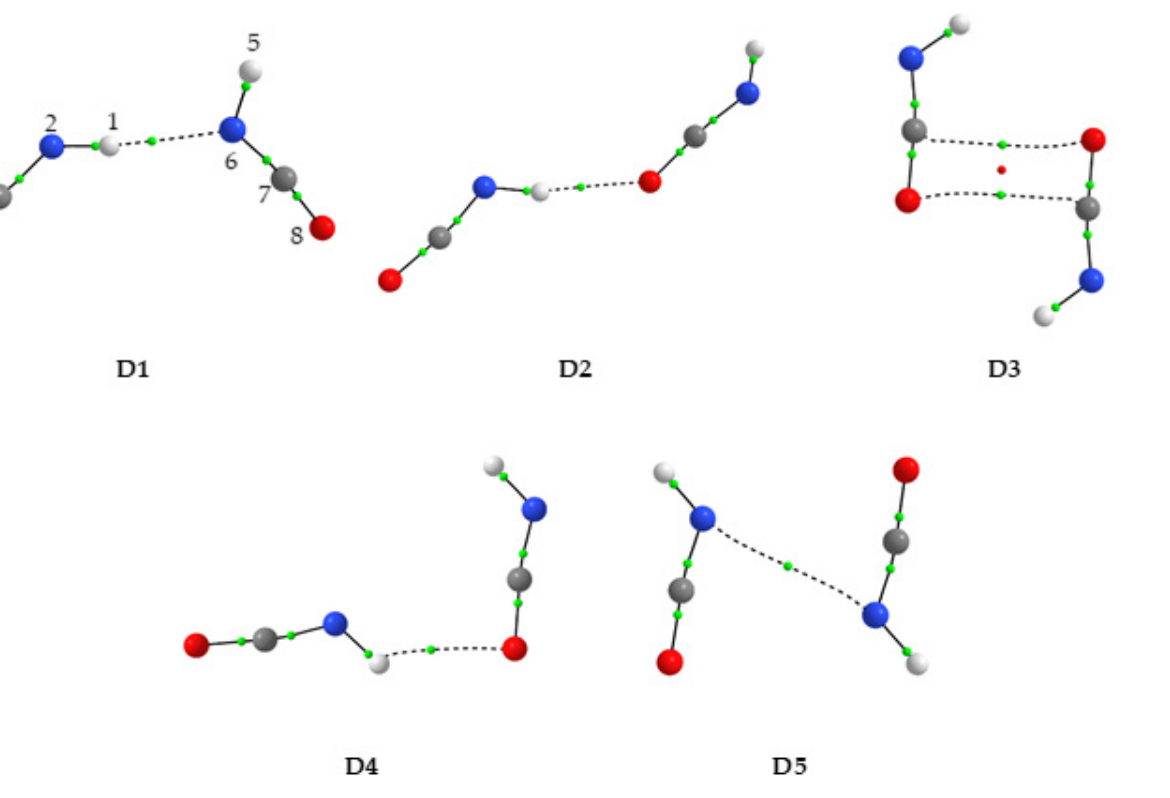
Figure 1. The MP2-optimized structures of the HNCO dimers. The H, N, C and O atoms are shown in white, blue, gray and red, respectively. The positions of the bond (3, − 1) and ring (3,+1) critical points derived from AIM calculations are shown by small green and red dots, respectively. Table 1. Interatomic distances (Å), angles (degree) and electron density parameters of the intermolec- ular bond critical points BCP (Atomic units) and ring critical points RCP (Atomic units) of the HNCO dimers computed at the MP2/6-311++G(3df,3pd)